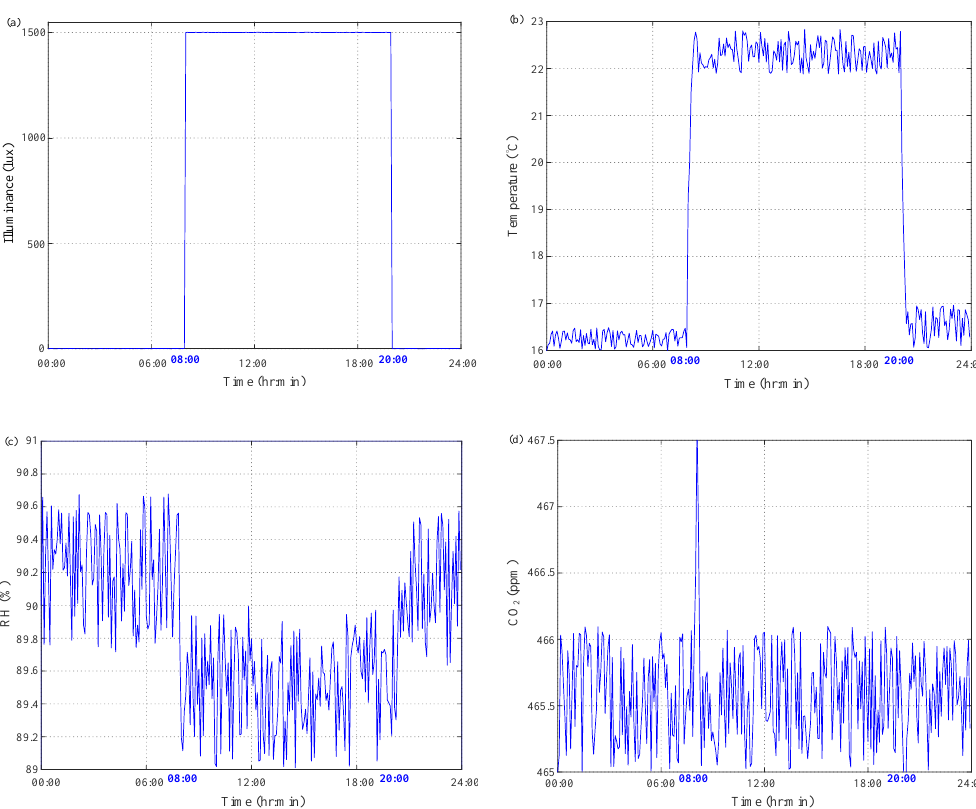
Figure 8. 24-h measurement results of on-site monitoring for fruiting body culture. ( a ) Illuminance; ( b ) temperature; ( c ) RH; ( d ) CO 2 .